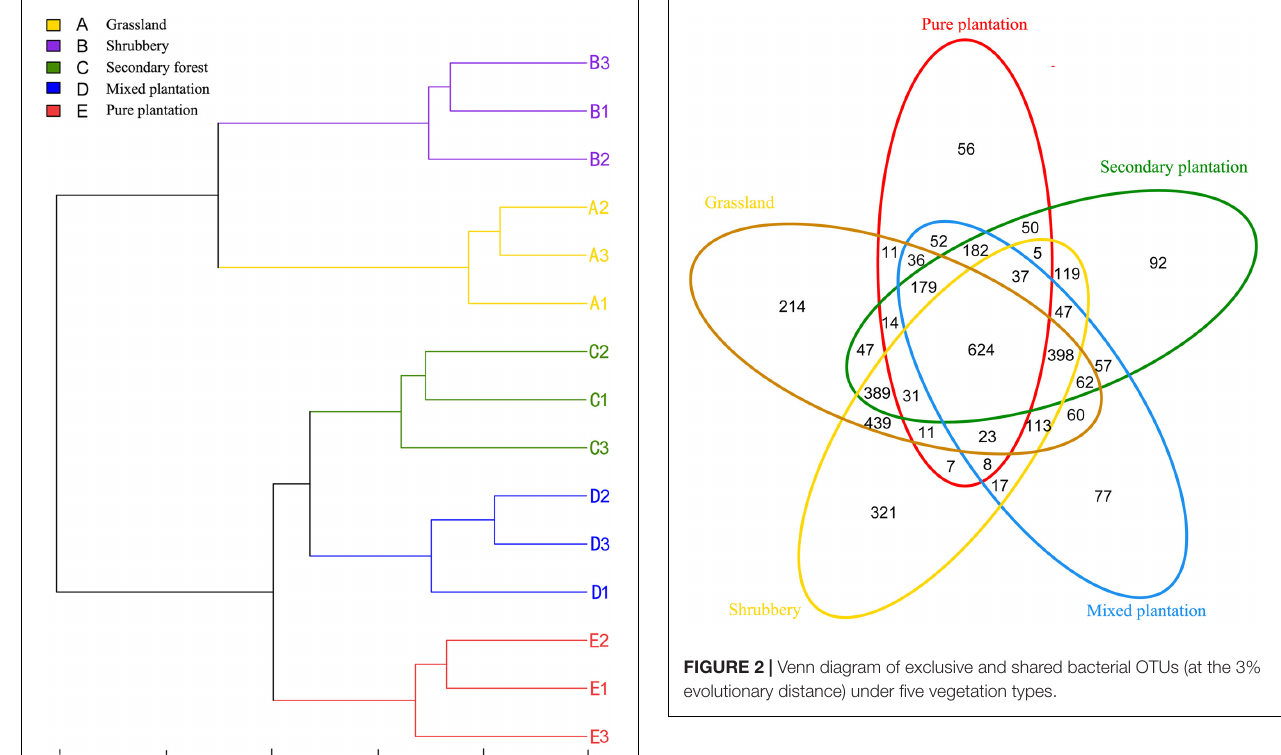
(49.53 and 5.57%), mixed plantation (50.20 and 5.55%), and